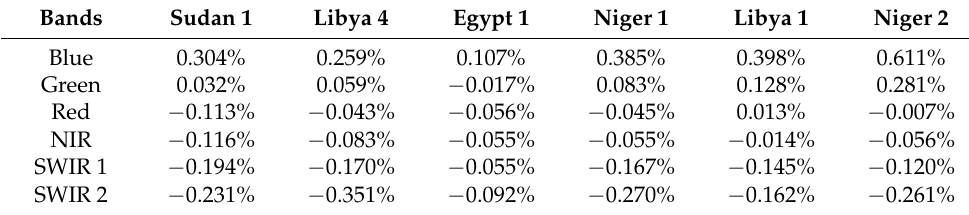
Figure 4. In red, the TOA reflectance predicted by the BRDF model; and in black, the observed TOA reflectance data of virtual constellation over Sudan 1 for blue, green, red, NIR, SWIR 1, and SWIR 2 bands. Table 5. BRDF model error (residual error) in percentage for all PICS sites in matching spectral